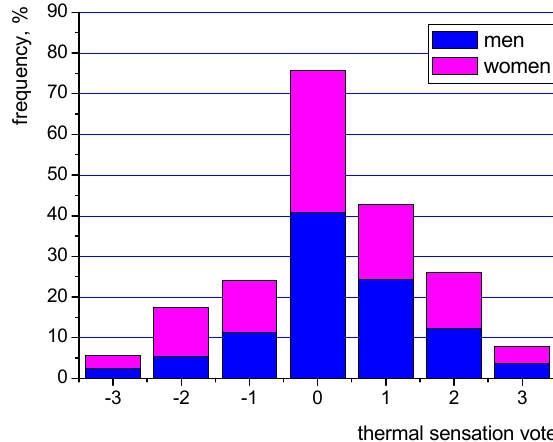
Figure 8. Thermal sensation vote of the room occupants in both intelligent buildings based on 1369 questionnaires (description in the text).